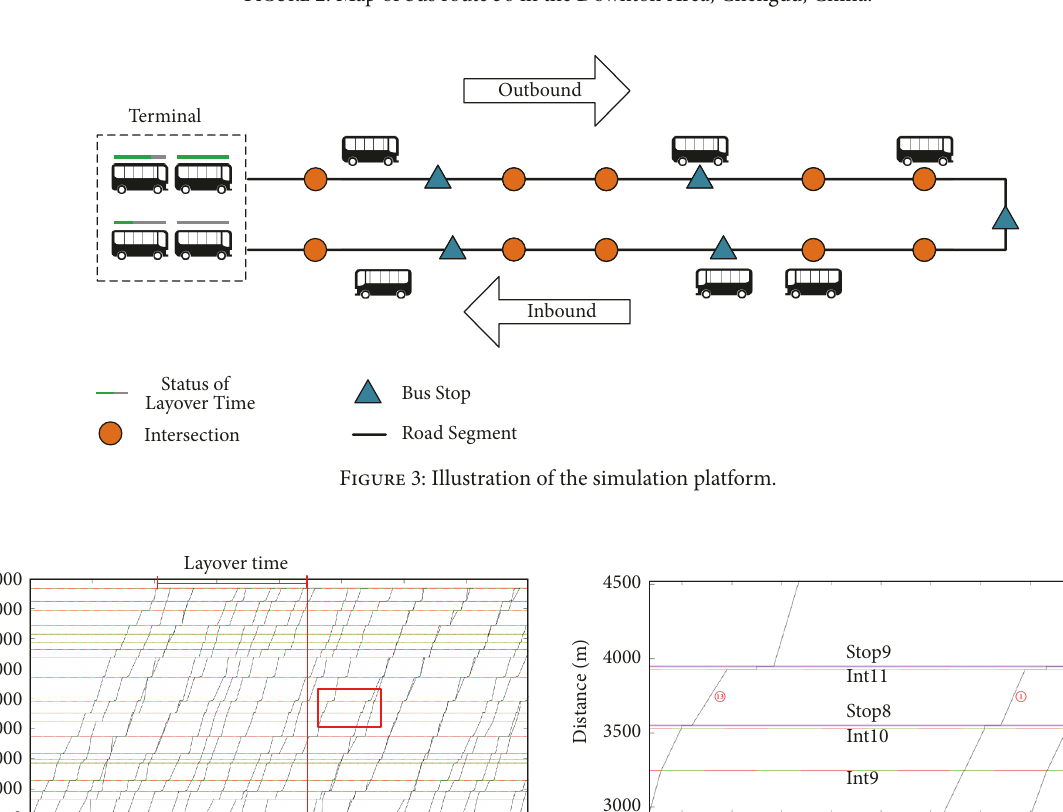
Figure 2: Map of bus route 56 in the Downton Area, Chengdu, China.